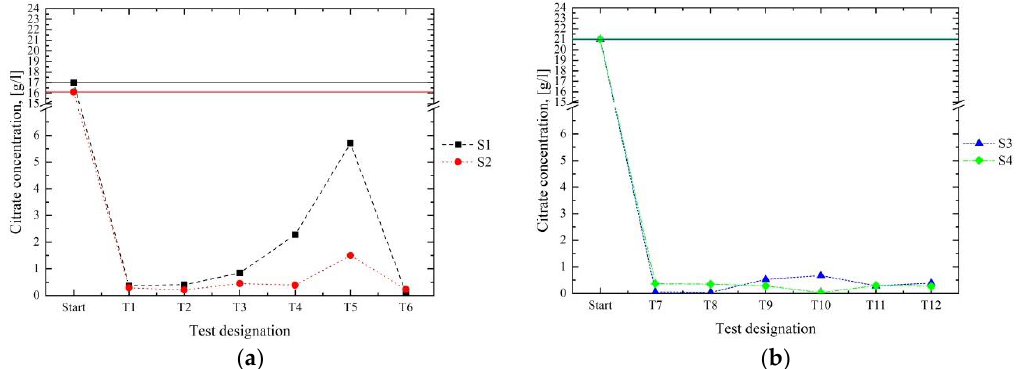
Figure 6. Concentration of the citrates in the initial solutions (start, continuous line) and the filtrates of series 1 ( a , T1 – T6) and series 2 ( b , T7 – T12) [3]. Table 3. Concentrations of the citrates and different metal ions of the treated solutions S1, S2, S3, and S4 after the first tests (T1 and T7, respectively) of series 1 and 2 (b.a.l., below the analytical limit of determination) measured by IC and ICP-MS and the reduction (Red.) in percentage with respect to the initial values given in Table 1 [3].